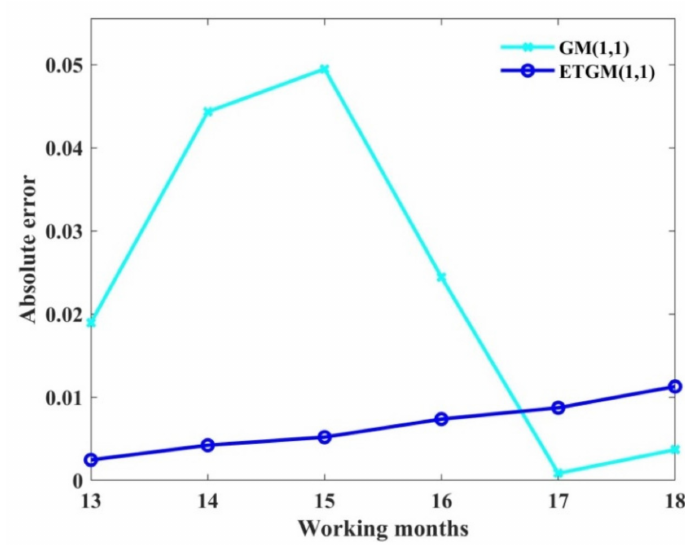
Figure 7. Absolute error